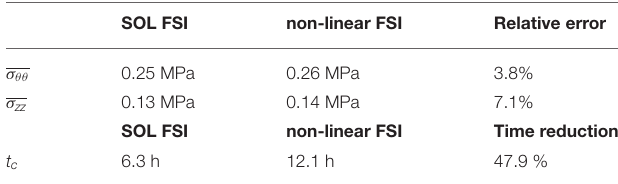
TABLE 3 | Table summarizing the average circumferential ( σ θθ ) and longitudinal ( σ zz ) stresses at peak systole, with the computational time for a single regime period ( t c ) for the SOL and non-linear